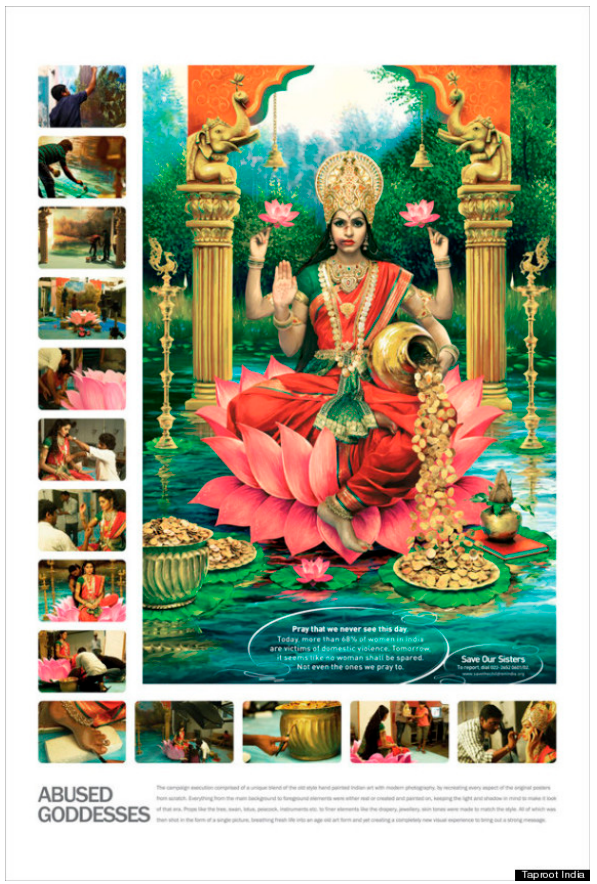
Figure 3. One poster (of three) from the Abused Goddesses campaign depicting the goddess Lakshmi. Image Courtesy: Taproot Dentsu.